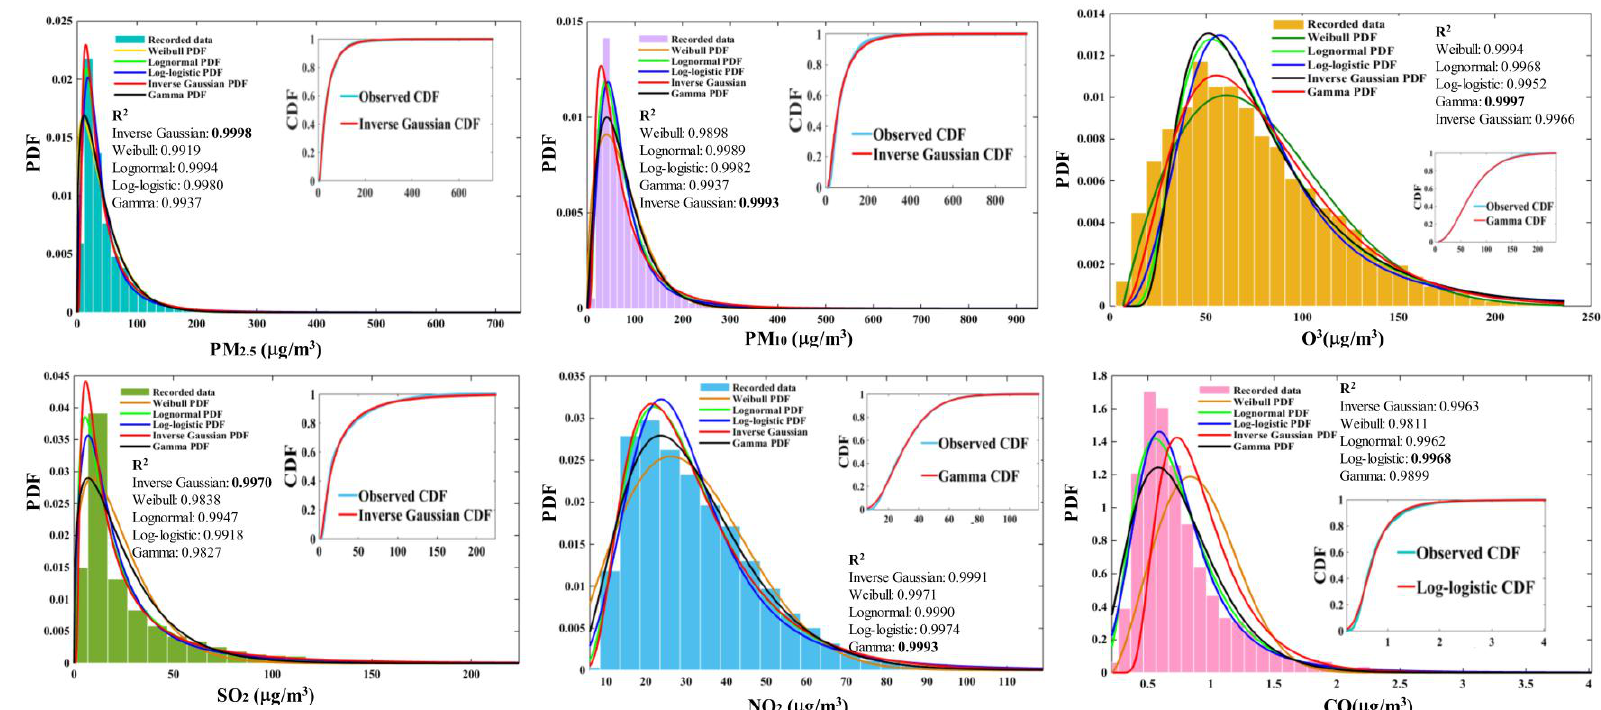
Figure 6. The statistical distribution characteristics of the air pollutant concentrations.